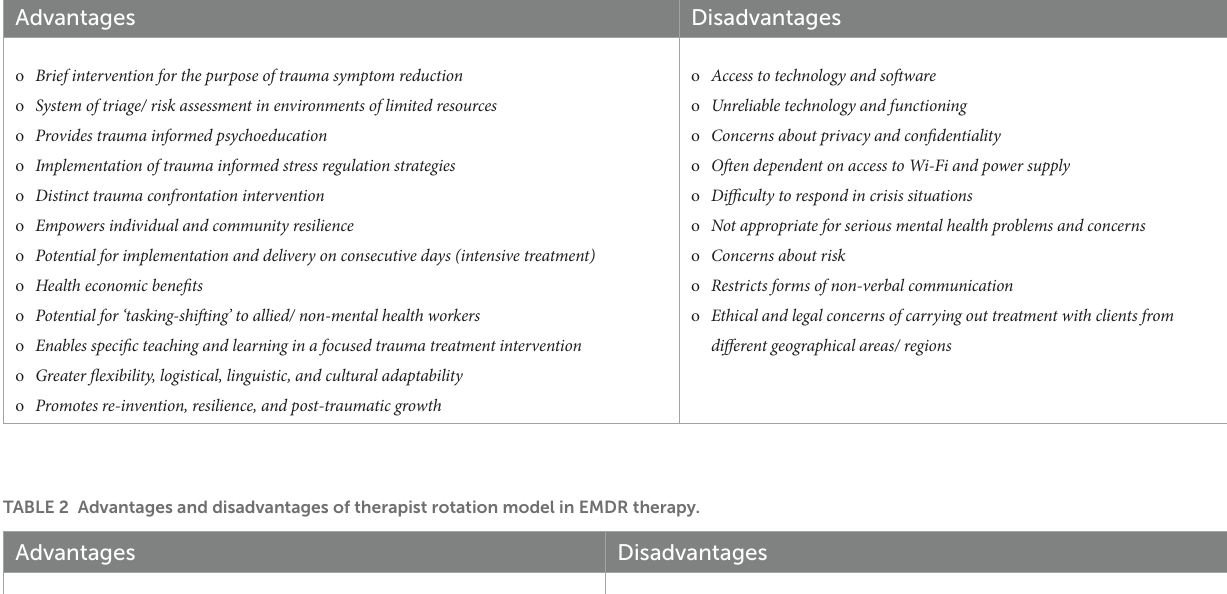
TABLE 1 Advantages and disadvantages of early intervention EMDR therapy using visual platforms.